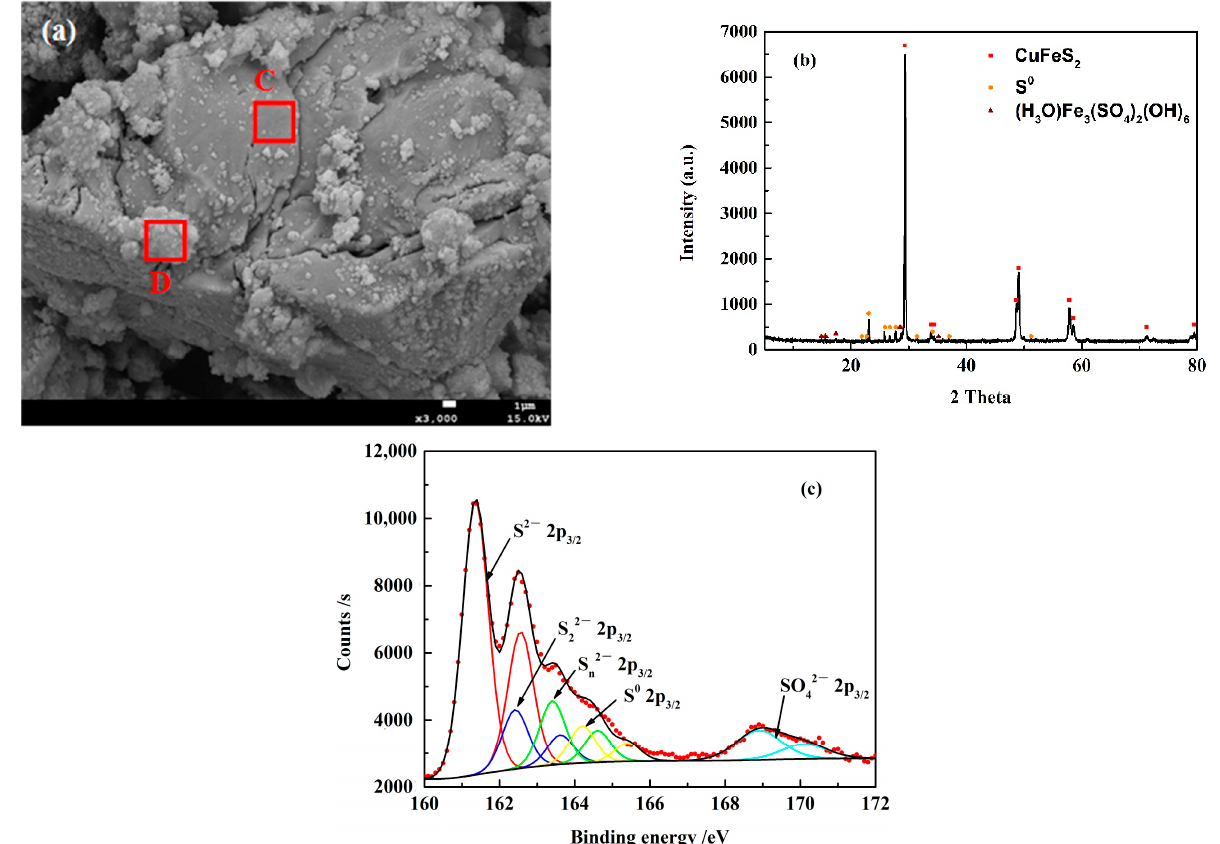
Figure 7. For the experimental group with a redox potential of 600 mV, solid phase SEM image ( a ), XRD image ( b ), and XPS image ( c ) at 23.5 h of chalcopyrite leaching. (C and D in the figure are EDS detection areas)